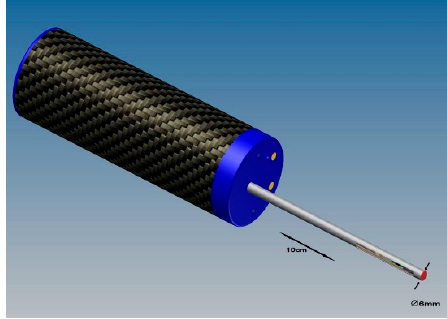
Figure 33. MicroProfiler-B with integrated feed-unit for up to 5 mm/s scanning speed inside deep bores.